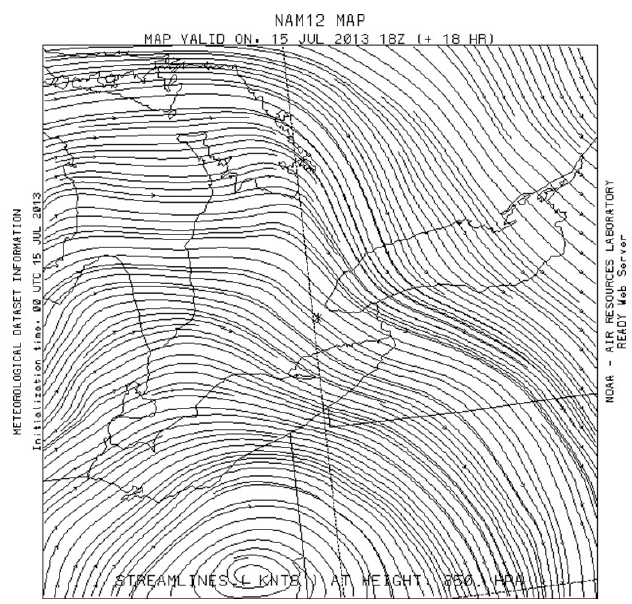
Figure 18. Streamlines at 850 hPa level, 15 July 2013, EDT 14:00. Credit: NOAA ARL.